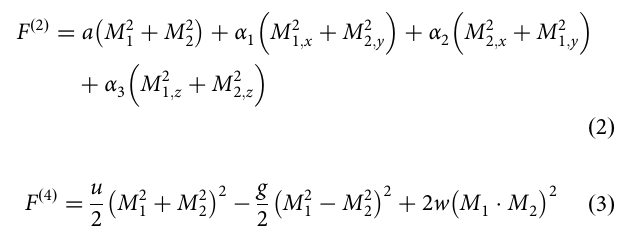
Fig. 3b. Phase fractions were identi fi ed from the nuclear re fi nement, and the magnetic phase fraction was matched to the main nuclear phase. The re fi ned magnetic moment for x ¼ 0 regime, similar to that observed in begins at ~0.6 µ B in the C a 2 M the 122s, drops continuously to ~0.2 µ B and remains roughly constant for compositions with x ≥ 0 : 3. The re fi ned magnetic moments were congruent with the observed magnetic Bragg re fl ection intensities, with Bragg peak magnitudes approximately scaling with the square of the moment, further indicating the positive identi fi cation of the magnetic phases.